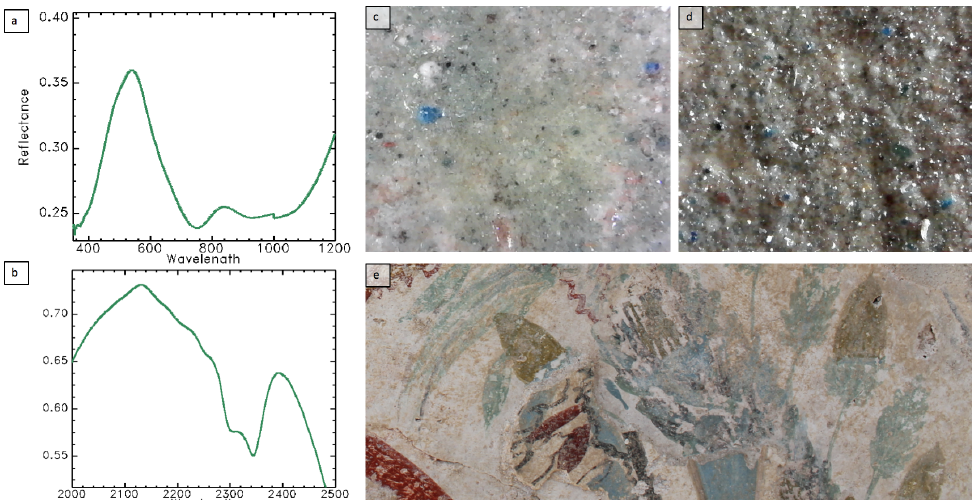
Figure 12. ( a,b ) Reflectance spectra featuring diagnostic absorption features of green earth (celadonite) in the visible range (400–1200 nm) and the short-wave infrared (2000–2500 nm) of a green painting fragment from the House of Orpheus. The following are photomicrographs (250x) of different wall painting fragments containing green earth: ( c ) light green hue consisting of green earth and Egyptian blue (E5); ( d ) dark olive green tone consisting of green earth, Egyptian blue, goethite, and a manganese-containing compound (E5); ( e ) example applications of various shades of green applied in Tomb 3882